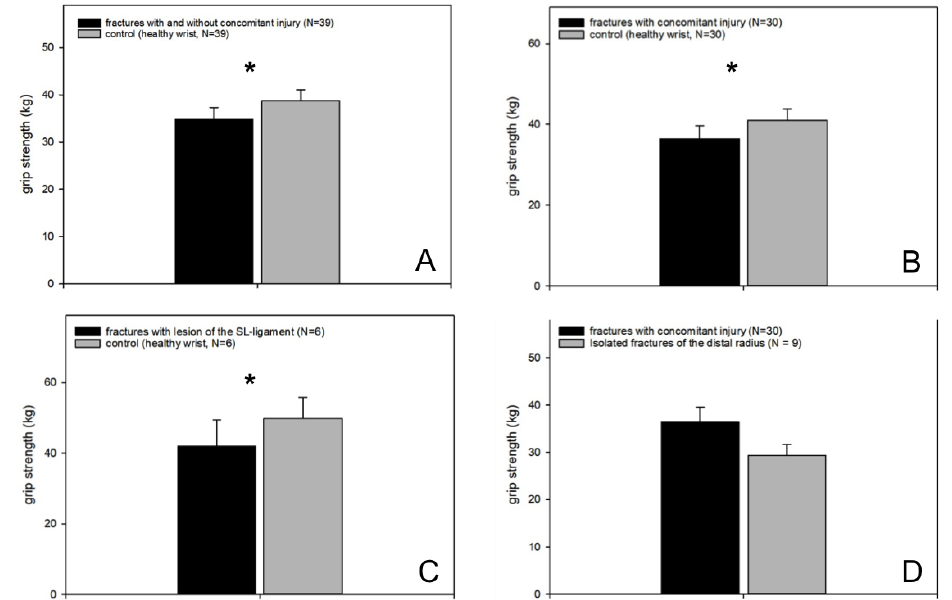
Figure 5. Grip strength. ( A ) Statistically significant reduced grip strength in the injured hand compared to the healthy wrist; ( B ) patients suffering from distal radius fractures with concomitant injuries had a significantly reduced grip strength compared to the healthy wrist; ( C ) patients suffering from distal radius fractures and SL ligament tears had a significantly reduced grip strength compared to the control; ( D ) no difference between patients suffering from isolated distal radius fractures and those with distal radius fractures and arthroscopically treated concomitant lesions.